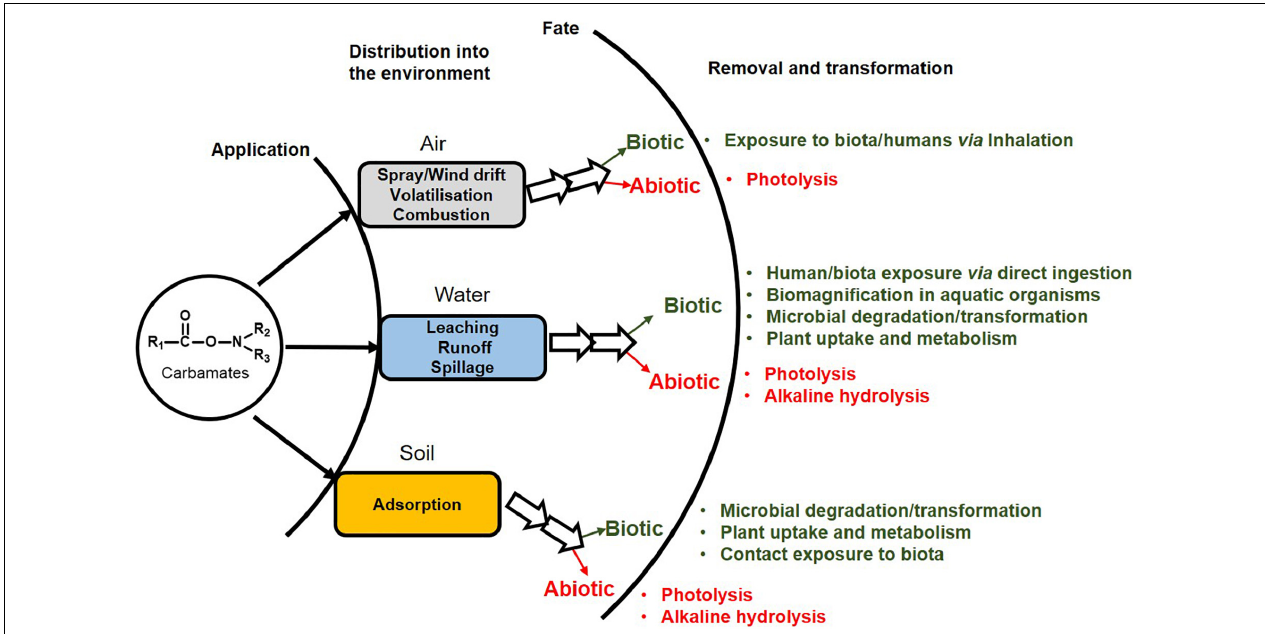
FIGURE 1 | Mode of entry of carbamate pesticides into the environment and their fate.